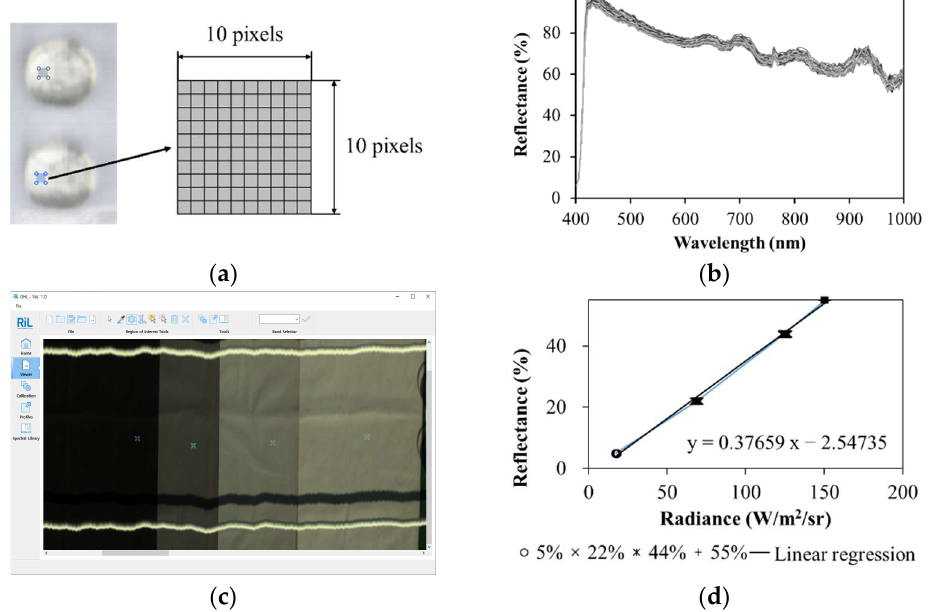
Figure 4. Extraction of spectral signatures from a hyperspectral image containing 19 chemicals using a mobile portable holder. ( a ) selection of specified pixels within a chemical container used as ingredient for building a spectral library for that chemical; ( b ) a bundle of hyperspectral signature extracted from selected pixels, where radiometric calibration was previously applied; ( c ) building radiance-reflectance relation using various reflectance tarps, where crossing point indicates a selected pixel corresponding to each reflectance percentile as well as raw radiance by the present hyperspectral camera (Corning microHSI); ( d ) a developed in-house software to make radiance-reflectance relation based on the previous step for conducting radiometric calibration and to apply the relations to entire bands and pixels.